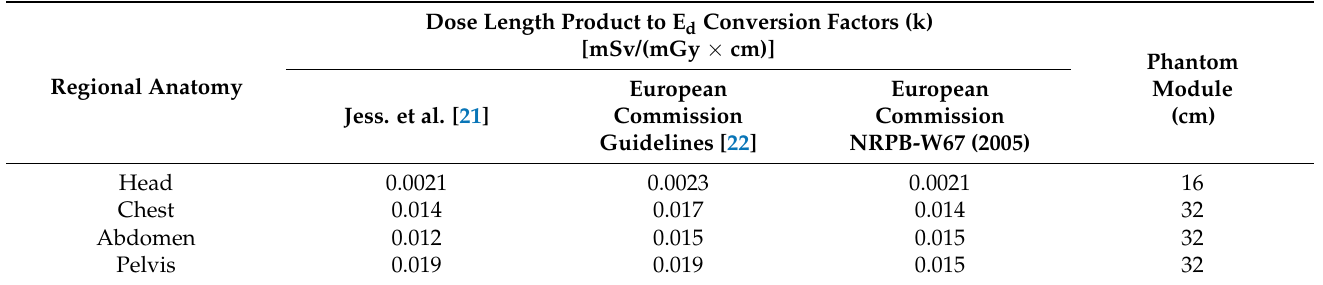
Table 2. Reported DLP to E d conversion factors.